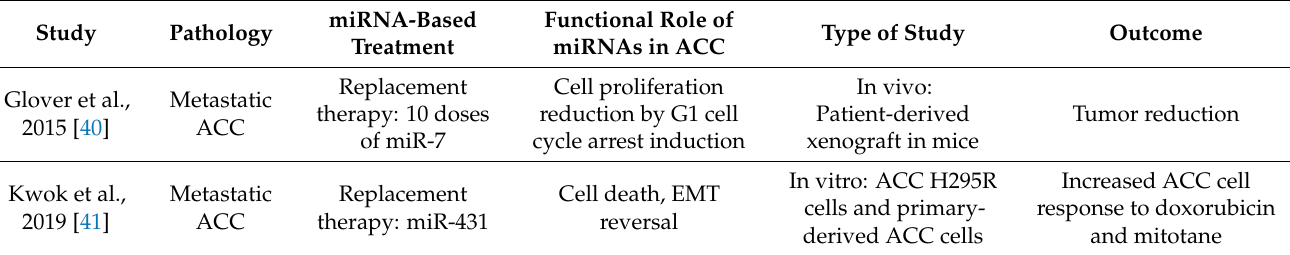
Table 3. MiRNA-based ACC